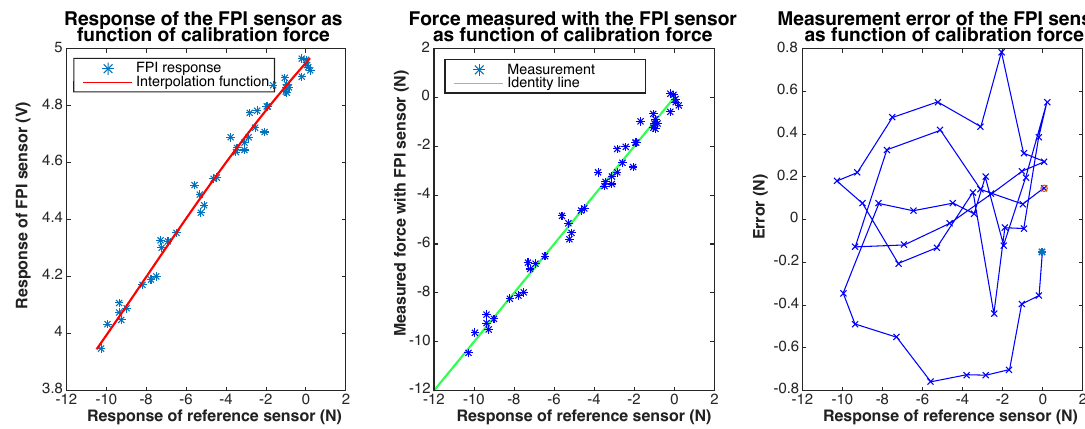
Figure 14. Results of static calibration of a proof-of-concept of the thin film concept. The response of the FPI as function of the calibration force, together with a fitted 3rd order polynomial interpolation function is shown on the left. The center figure shows the force measured with the FPI, calculated using the interpolation function, as function of the calibration force and the indentity line ( y = x ) as a reference. The measurement error of the FPI sensor as function of the calibration force is shown on the right.